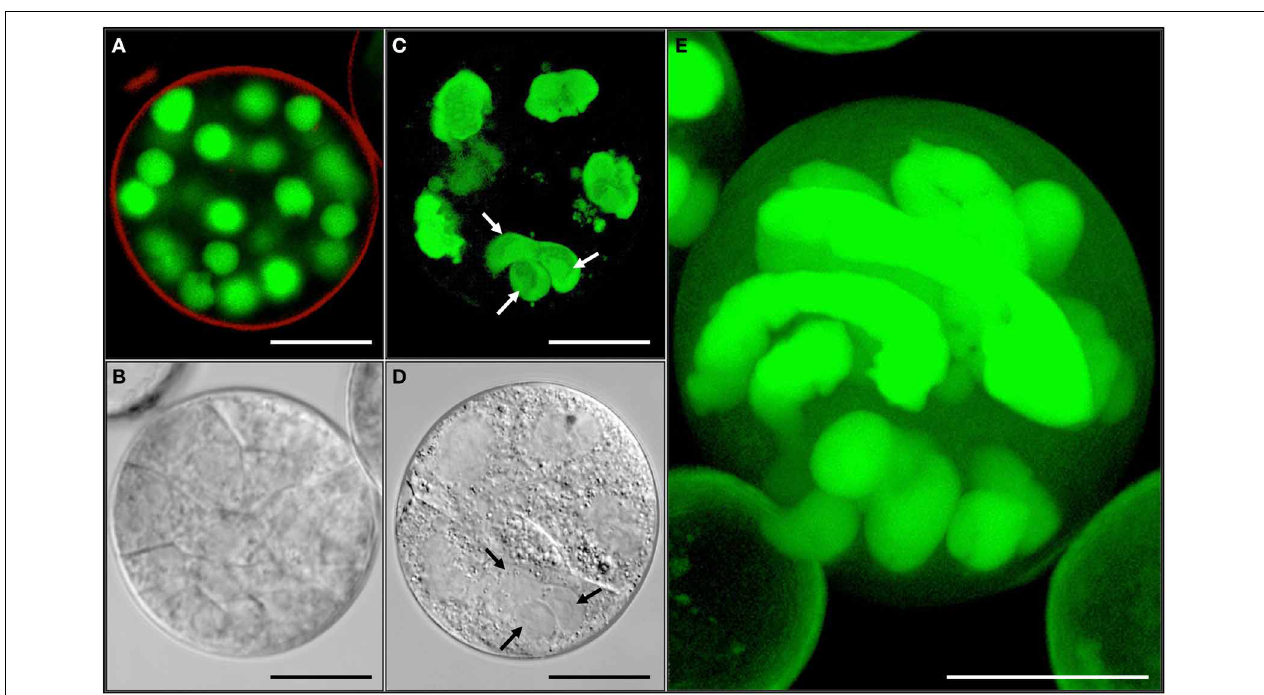
FIGURE 8 | Variable ploidy level in a multicellular structure shown by synchronously acquired DIC and fluorescence images. (A,C,E) GFP. (B,D) DIC. (A,B) Haploid multicellular structure with cell walls and spherical nuclei. (C,D) Chimeric polyploid multicellular structure with irregular shaped nuclei